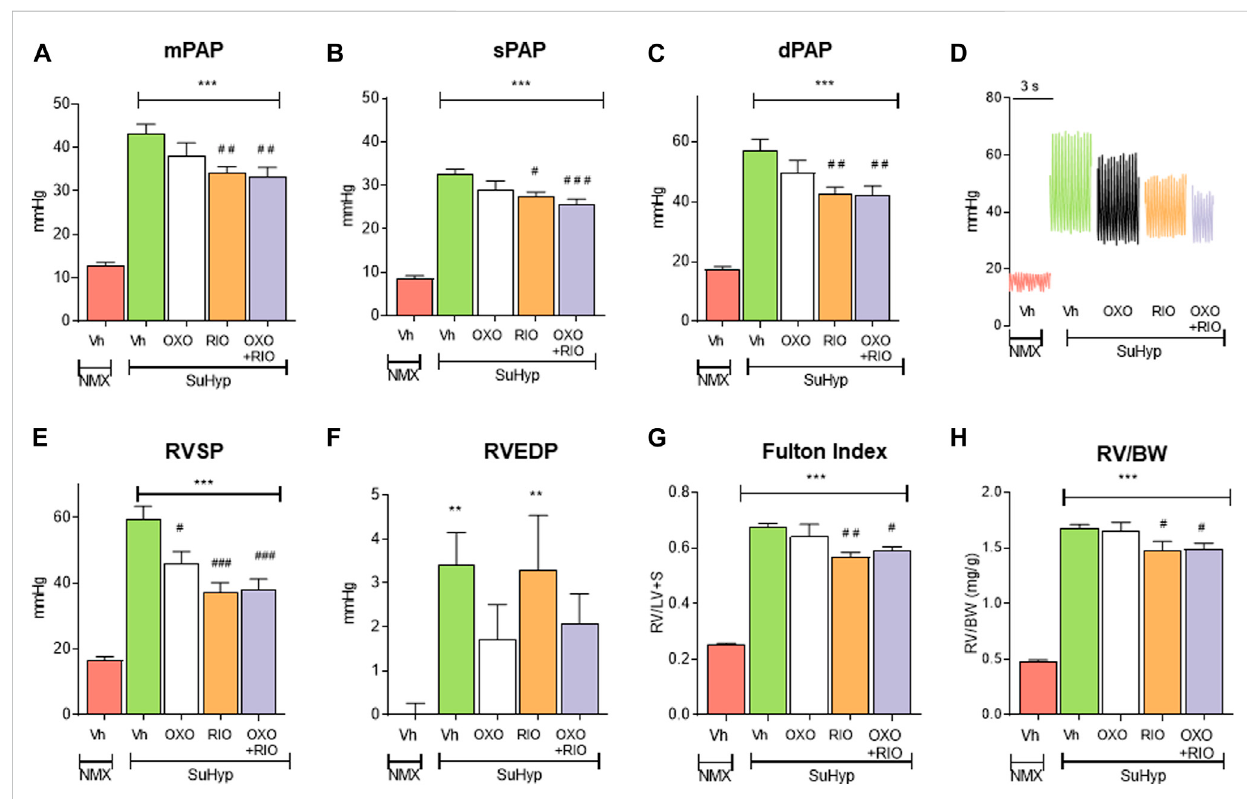
FIGURE 2 Treatment with riociguat alone or combined with 5-z-7oxozeaenol attenuates pulmonary hypertension in the Sugen 5,426/hypoxia (SuHyp) rat model. (A) Mean pulmonary arterialpressure(mPAP), (B) systolic PAP (sPAP) and (C) diastolic PAP (dPAP) incontrol (NMX-Vh)andSuHyp rats treated with vehicle, 5Z-7-oxozeaenol (SuHyp-OXO; 3 mg kg − 1 · day − 1 ), riociguat (SuHyp-RIO; 3 mg kg − 1 · day − 1 ) or both drugs combined (SuHyp-OXO-RIO). (D) Representative PAP recordings in each treatment group. (E) Right systolic and (F) end-diastolic ventricular pressure (RVSP and RVEDP). (G) Fulton index (ratio between RV and left ventricle plus septum weight) and (H) RV weight relative to total body weight in the different treatment groups. Each bar shows the mean +SEM ( n = 6-10 animals in each group). * p < 0.05 versus NMX-Vh and # p < 0,05 versus SuHyp vehicle (One-way ANOVA followed by Bonferroni´s post hoc